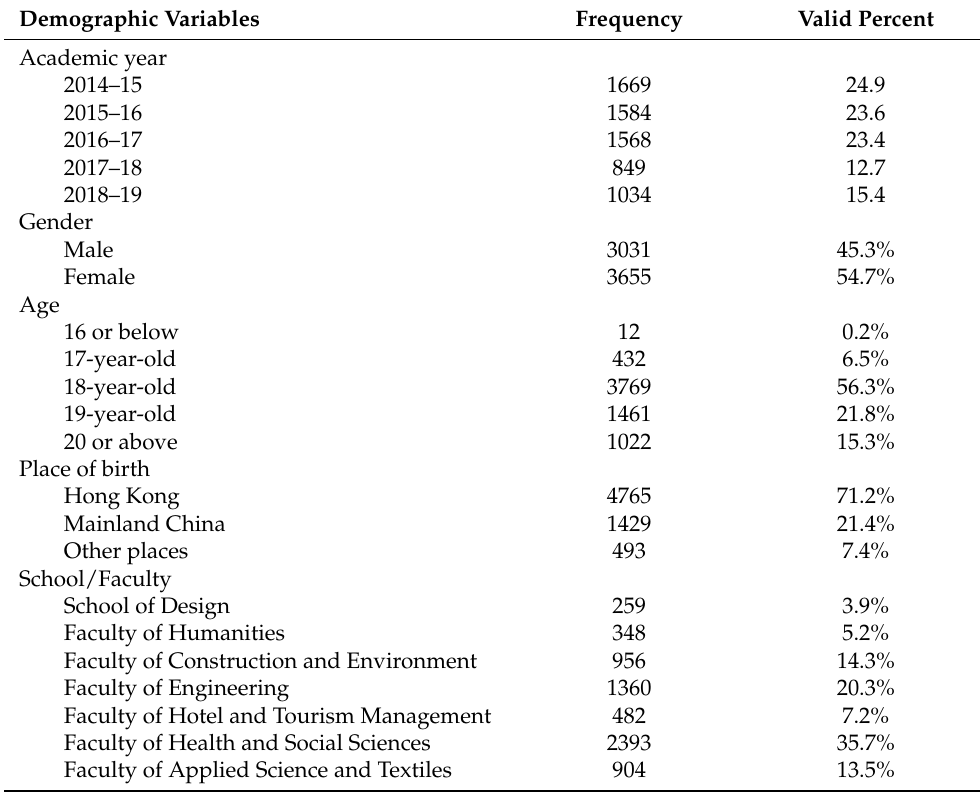
Table 1. Demographic information of all participants ( n =